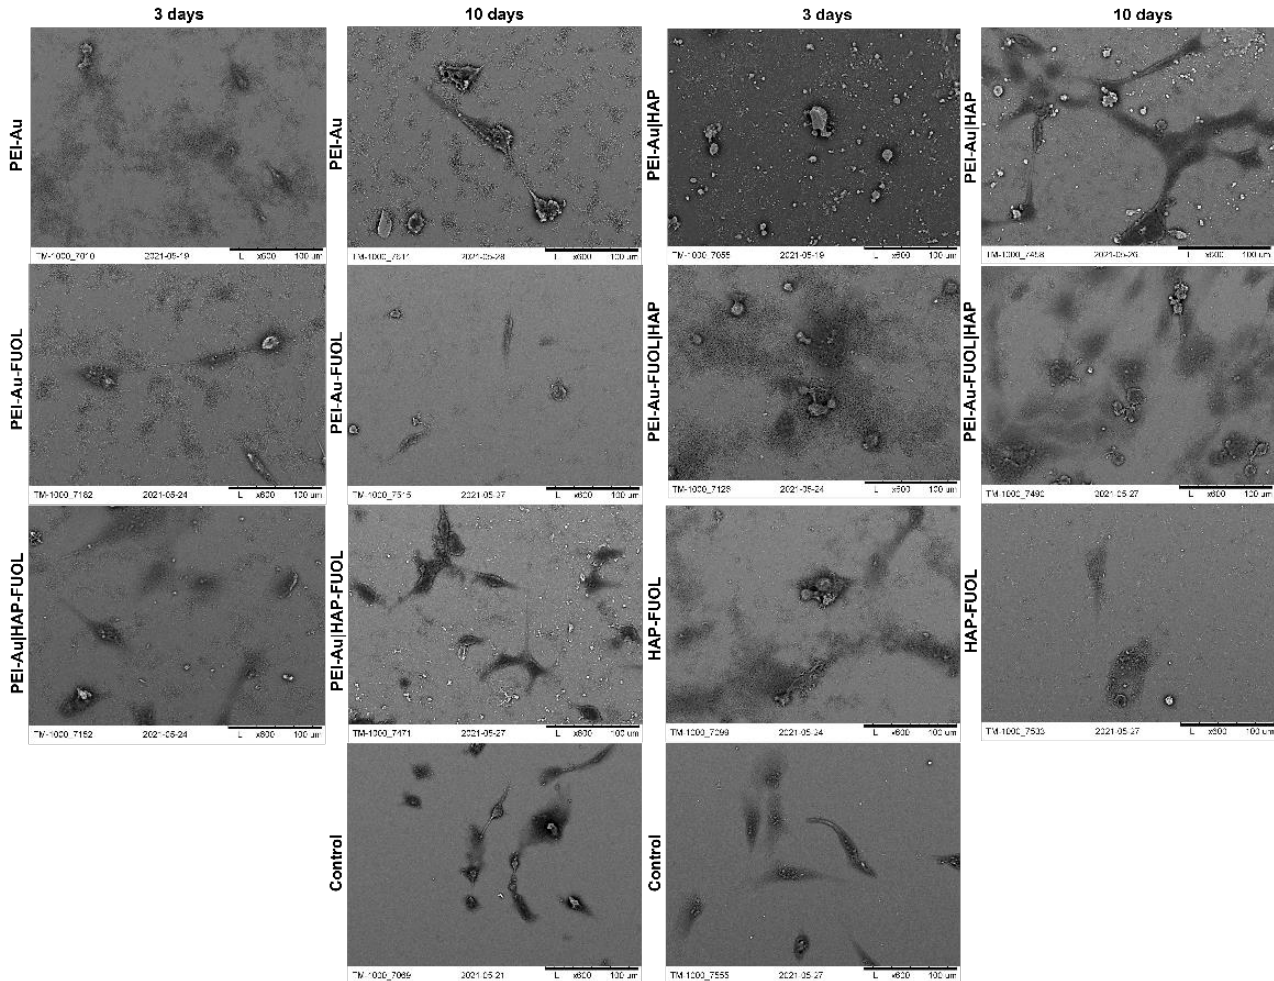
Figure 6. SEM visualization of hFOB cells immobilized within designed scaffolds after 3- or 10-day culture. As a control, served cells cultured on glass slides without the membranes. Key to the symbols: PEI-Au: the membrane built of the polyethylenimine with AuNPs incorporating; PEI-Au|HAP: bilayer consisting of polyethylenimine with AuNPs incorpo- rating and hydroxyapatite; PEI-Au-FUOL: polyethylenimine with AgNPs and FUOL incorporating; PEI-Au-FUOL|HAP bilayer consisting of polyethylenimine with AuNPs and FUOL incorporating and hydroxyapatite; PEI-Au|HAP-FUOL bilayer consisting of polyethylenimine with AuNPs incorporating and hydroxyapatite with FUOL incorporating; HAP- FUOL: hydroxyapatite with FUOL incorporating. Scale bar: 100 µm.